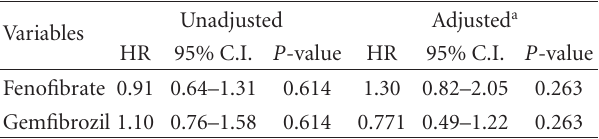
Table 2: Cox analysis of fibrate prescriptions in the population, 2005–2010. Unadjusted Adjusted a Variables 95% C.I. P -value Fenofibrate 0.91 0.64–1.31 0.263 a Adjusted for gender, age, and mean dose. Multiple Cox regression models were used to estimate the relationship between sex, age, medication, and mean dose of fibrates and development of